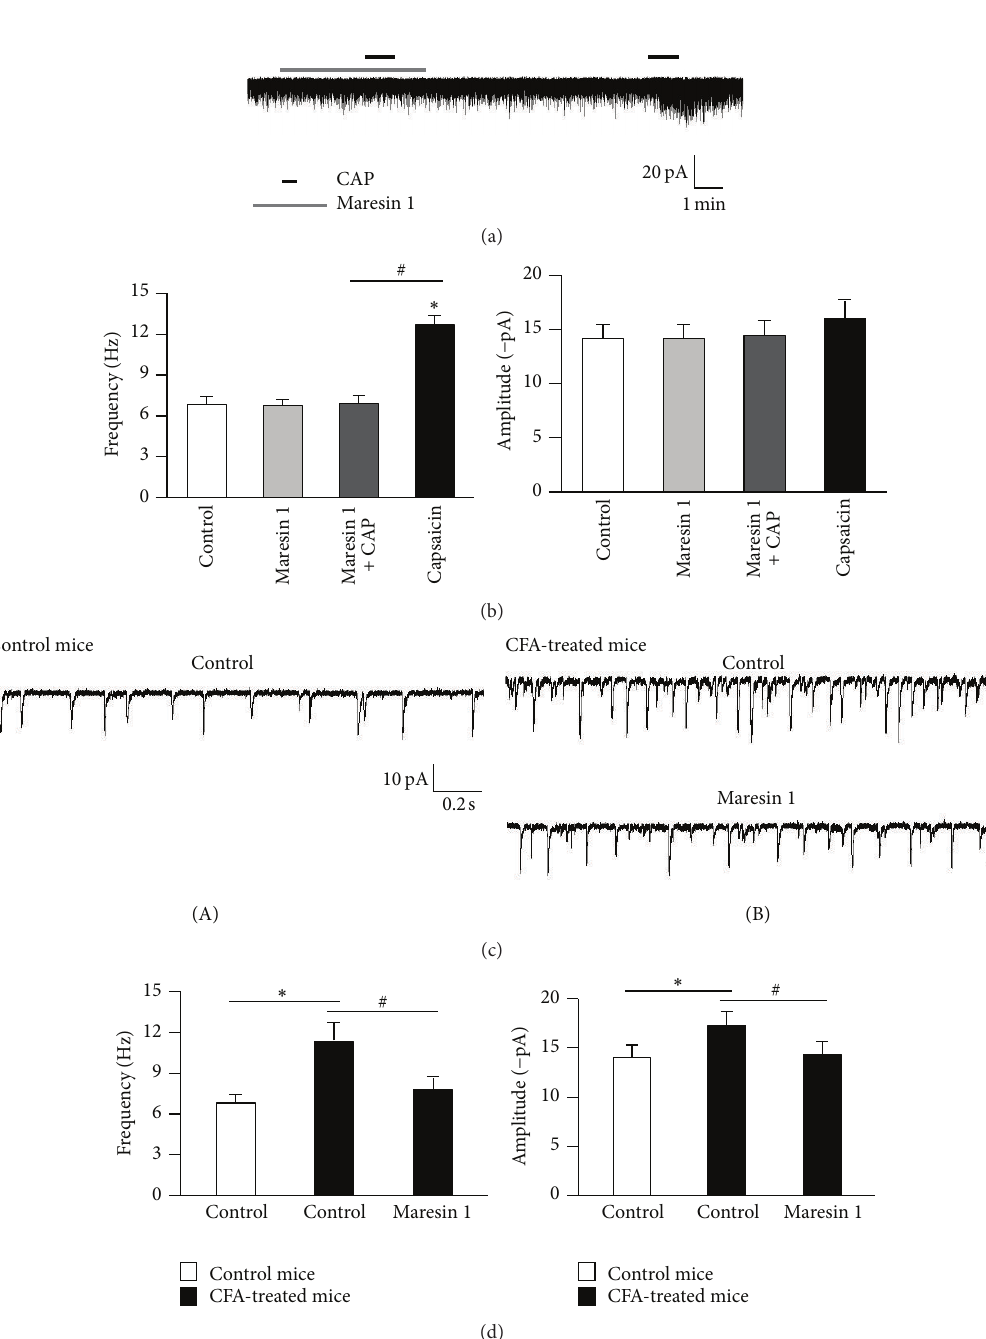
Figure 4: Maresin 1 abolishes capsaicin- (CAP-) induced enhancement in synaptic transmission and TMJ inflammation-induced synaptic plasticity in the trigeminal nucleus. (a) Spontaneous excitatory postsynaptic currents (sEPSCs) traces in Sp5C lamina II neurons of trigeminal nucleislicesbeforeandaftercapsaicin(500 nM)andmaresin1perfusion(0.35 nM).(b)Maresin1(0.35